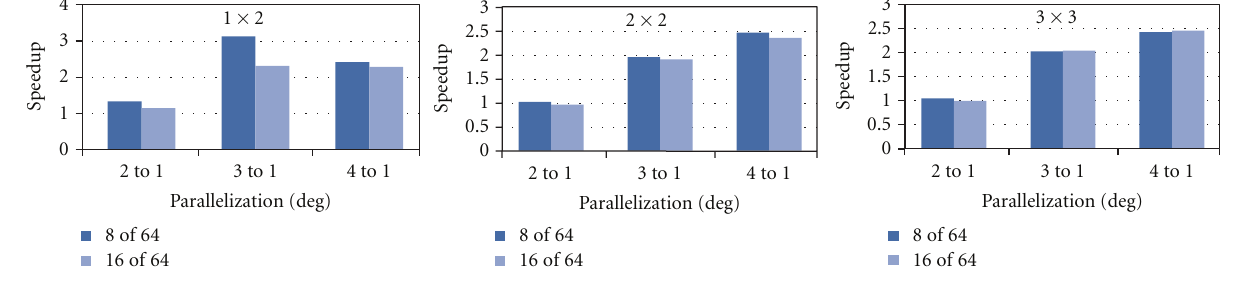
Figure 11: Results parallelization benchmark.